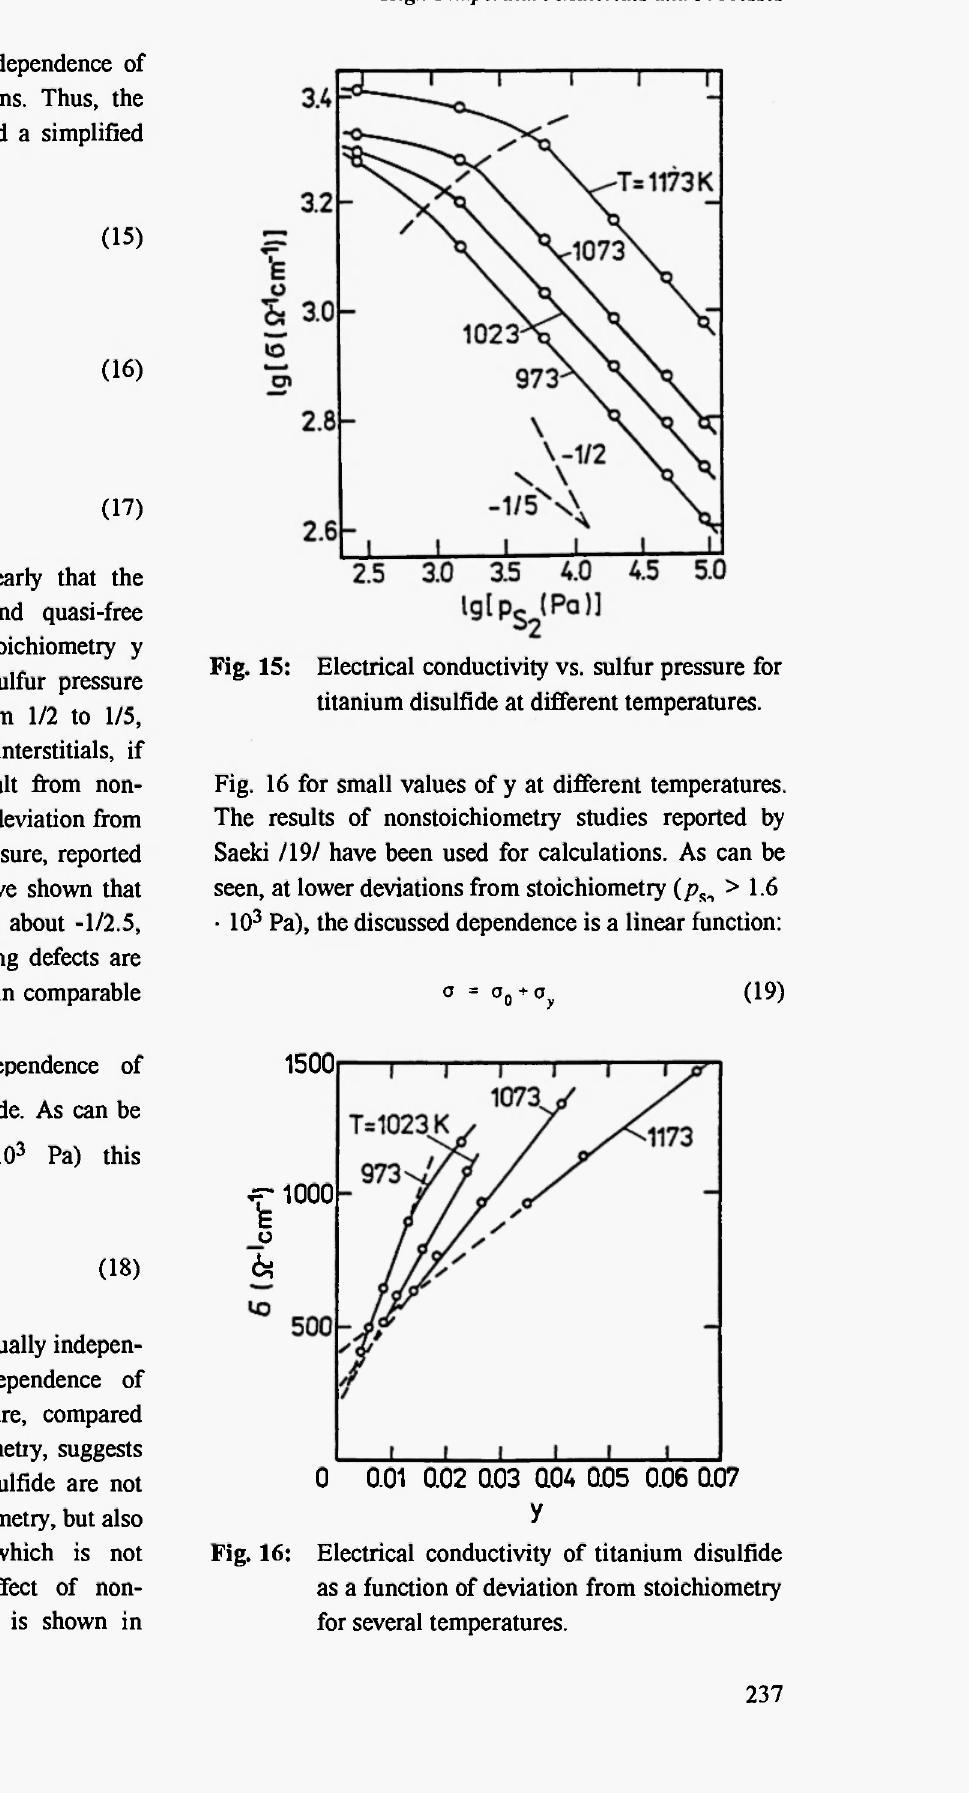
Fig. 16: Electrical conductivity of titanium disulfide as a function of deviation from stoichiometry for several